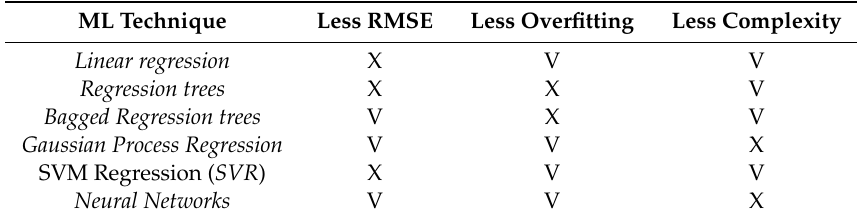
Table 19. Comparison among ML